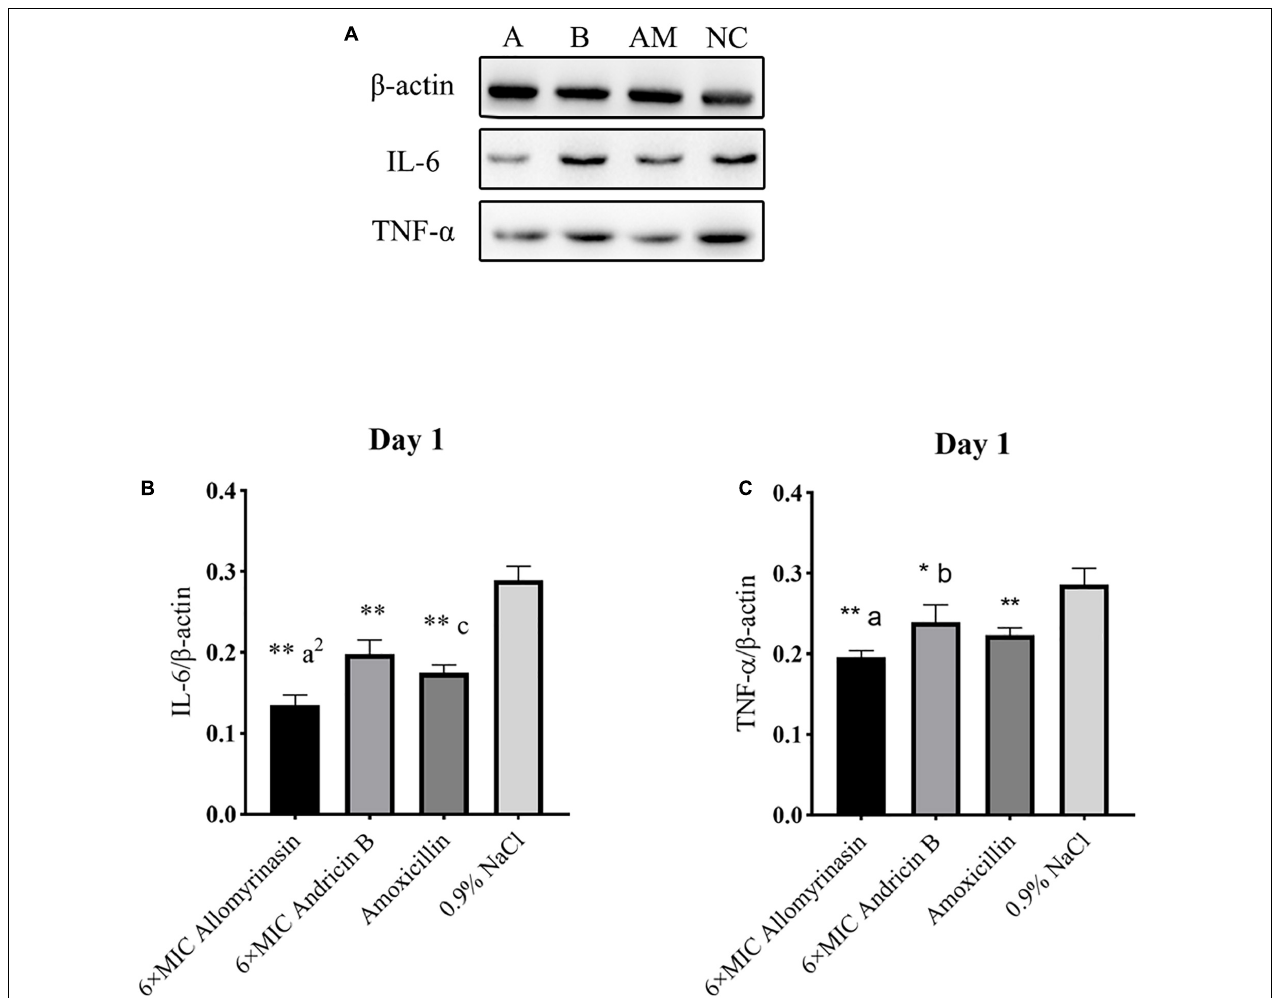
FIGURE 11 | Allomyrinasin inhibited the proinflammatory cytokines IL-6 and TNF- α on day 1 after skin infections induced by Staphylococcus pseudintermedius MW767056. (A) Western blotting analysis of IL-6 and TNF- α expression in the skin tissues of mice. (B,C) Expression of IL-6 and TNF- α , with β -actin as the internal control, in the infected skin is shown as bar graphs. Data with error bars are presented as the mean ± SD ( n = 3). (A) 6 × minimal inhibitory concentration (MIC) allomyrinasin. (B) 6 × MIC andricin B. AM, amoxicillin; NC, 0.9% NaCl. * p < 0.05, ** p < 0.01, compared with saline group; a p < 0.05, a2 p < 0.01, compared with group treated with andricin B; b p < 0.05, b2 p < 0.01, compared with group treated with